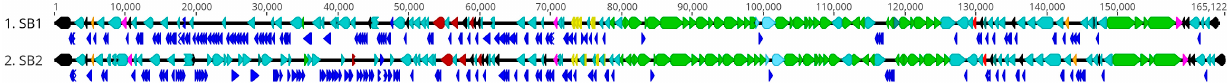
Table 3. InterProScan database hits on DLP1 and DLP2 DHFR. The data represent findings for both phages due to identical search results.